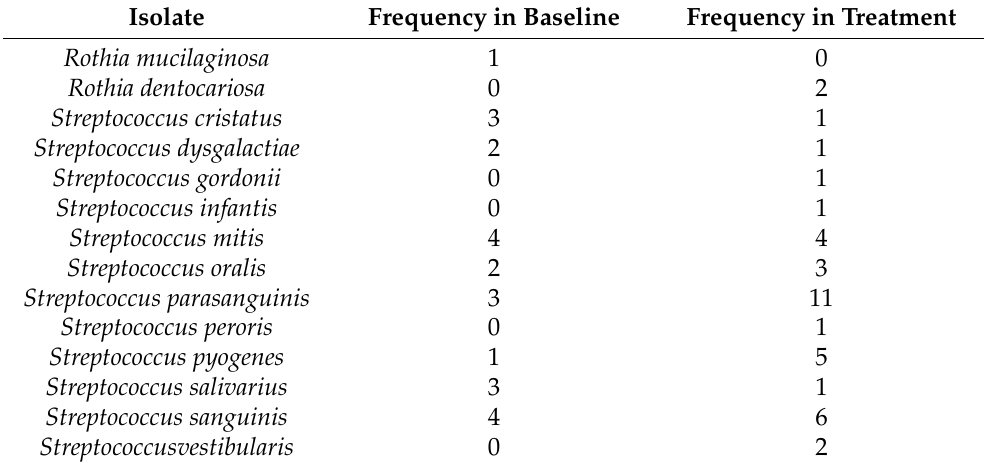
Table 3. Number of inhibitory isolates against pathogenic Neisseria species before and after treatment. Isolate Frequency in Baseline Frequency in Treatment Rothia mucilaginosa 1 0 Rothia dentocariosa 0 2 Streptococcus cristatus 3 1 Streptococcus dysgalactiae 2 1 0 1